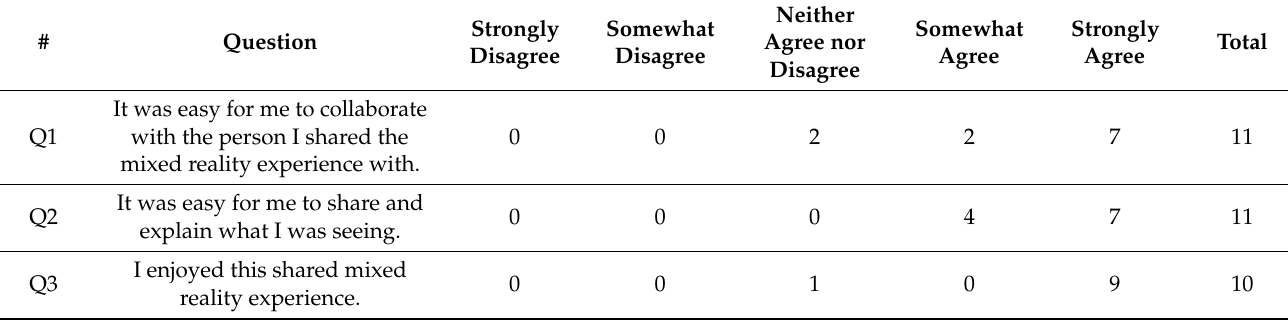
Table 3. This table shows participants ( n = 11) response to survey items scored on 5-scale Likert (strongly disagree = 1, somewhat disagree = 2, neither agree nor disagree = 3, somewhat agree = 4, and strongly agree = 5), open question presented to participants, and predefined interview